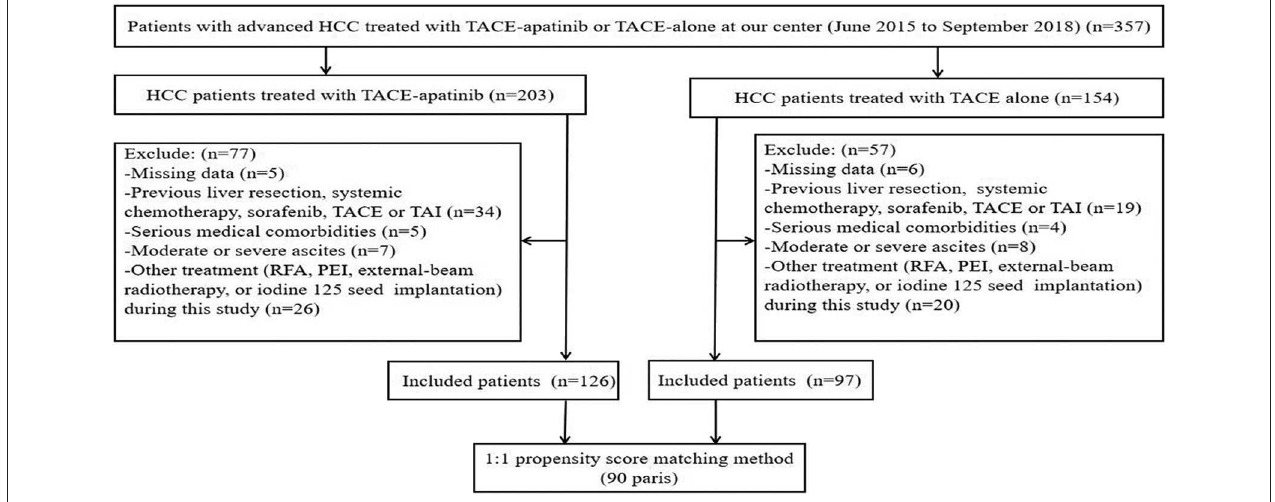
FIGURE 1 | Flow diagram of patient selection. HCC, hepatocellular carcinoma; TACE, transarterial chemoembolization; TACE–apatinib, TACE combined with apatinib; TAI, transarterial chemoinfusion; RFA, radiofrequency ablation; PEI: percutaneous ethanol injection.